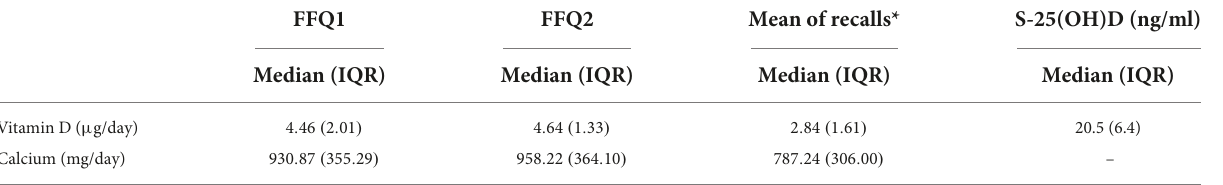
TABLE 2 Daily vitamin D and Ca intakes assessed by FFQ1, FFQ2, and 24-h recalls and S-25(OH)D ( n = 84). FFQ1 FFQ2 Mean of recalls*